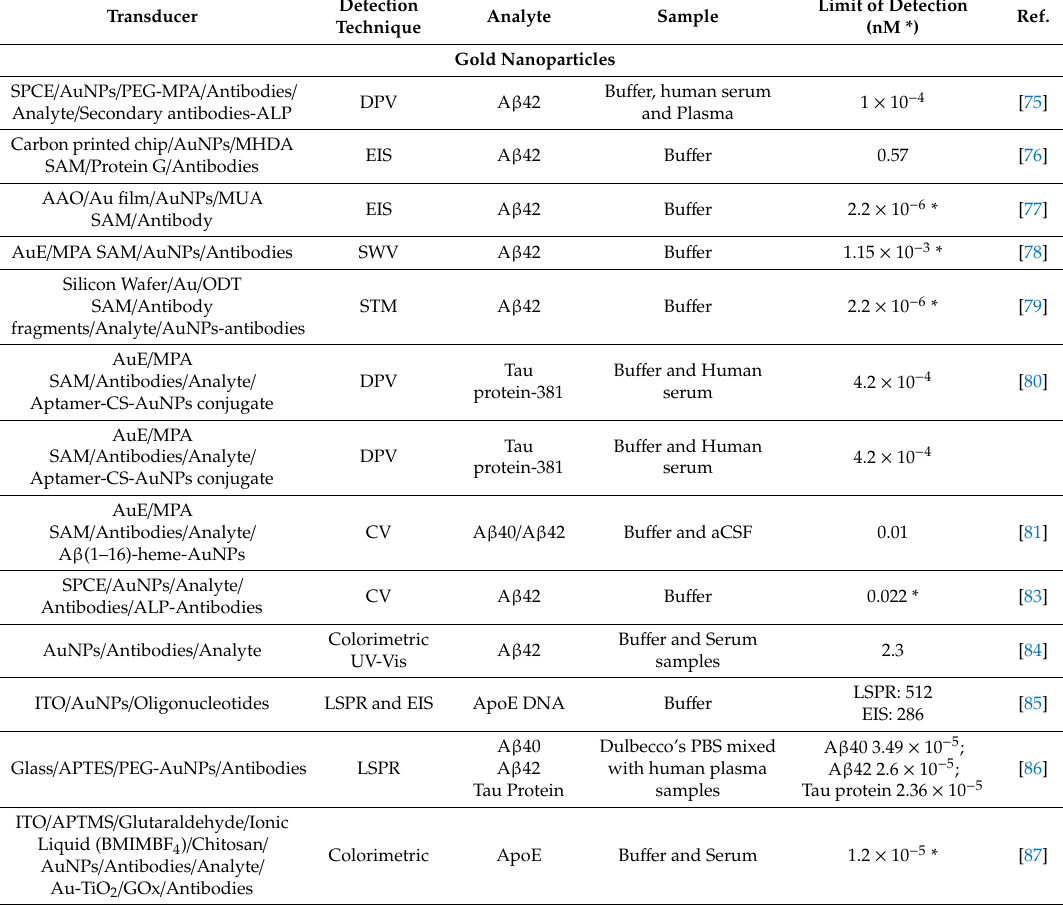
Limit of Detection Ref. (nM *)